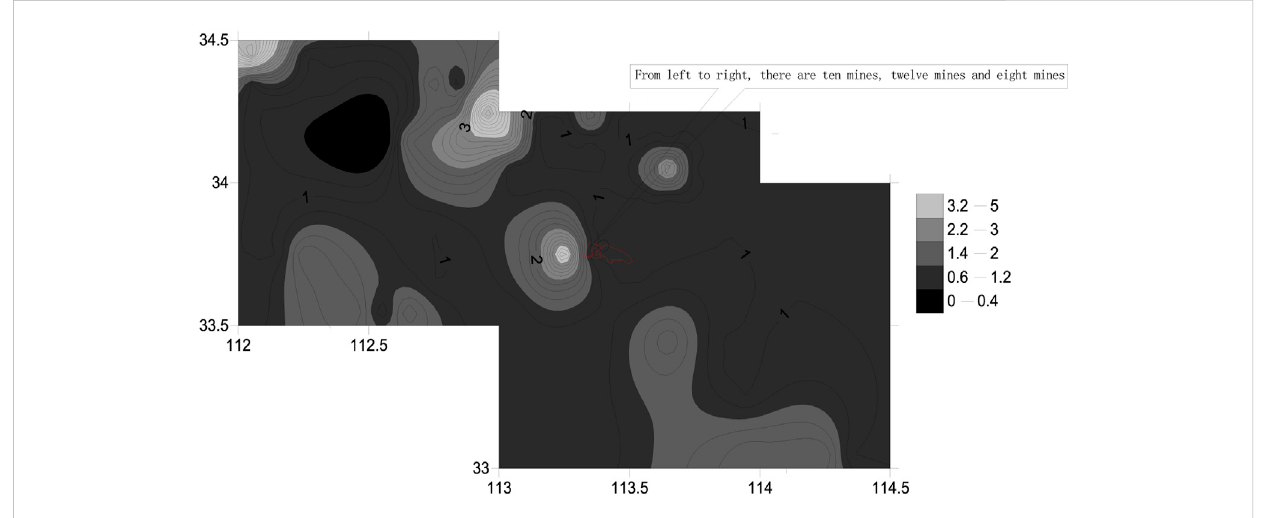
FIGURE 7 Isoline of seismic frequency in the research